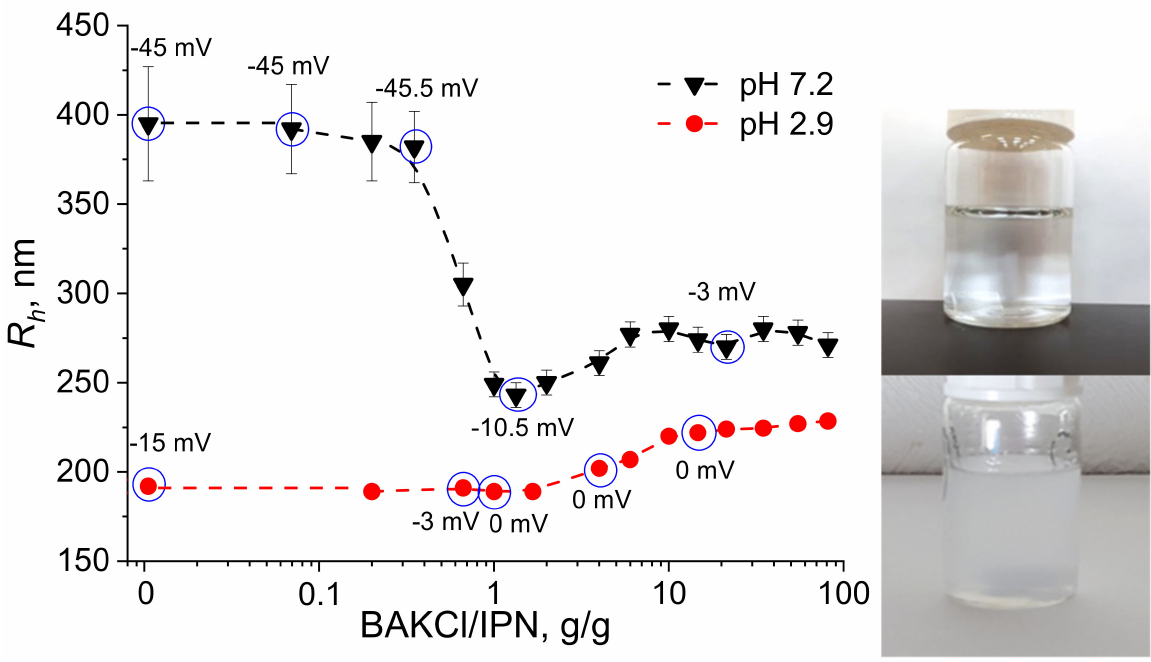
Figure 2. Plots of hydrodynamic radius R h versus the amount of BAKCl added to the aqueous dispersion of PNIPAAm-PAA IPN at pH 7.2 and 2.9. Zeta potential values are added above blue circles of corresponding measurements. Right image—the microgel dispersion before (upper image) and after (lower image) BAKCl